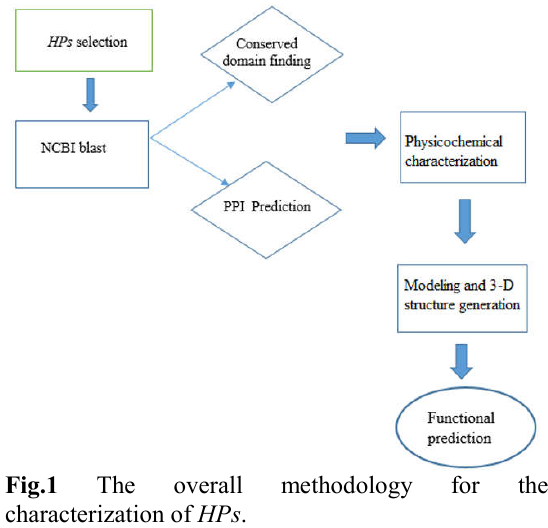
Fig.1 The overall methodology for the characterization of HPs